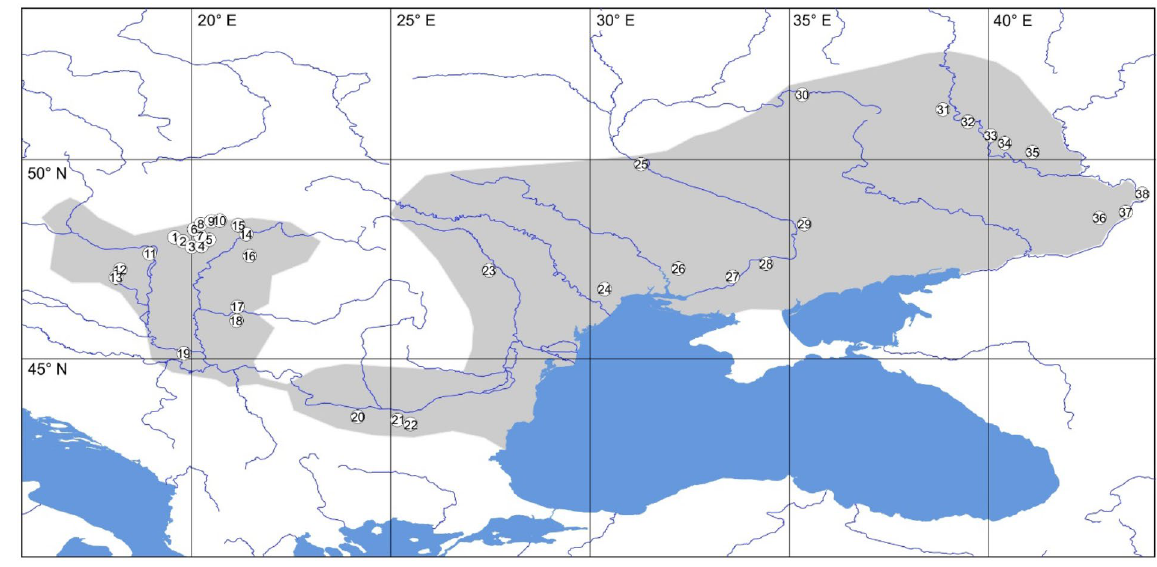
Figure 1. Distribution map of Lethrus apterus (shaded area) after Bagaturov and Nikolajev 24 , populations sampled for the current study are numbered according to Table 1. The map was created in QGIS v.3.10 ( http:// www. qgis. org/ ) using geospatial layers downloaded from the freely available dataset Natural Earth ( https:// www. natur alear thdata. com/